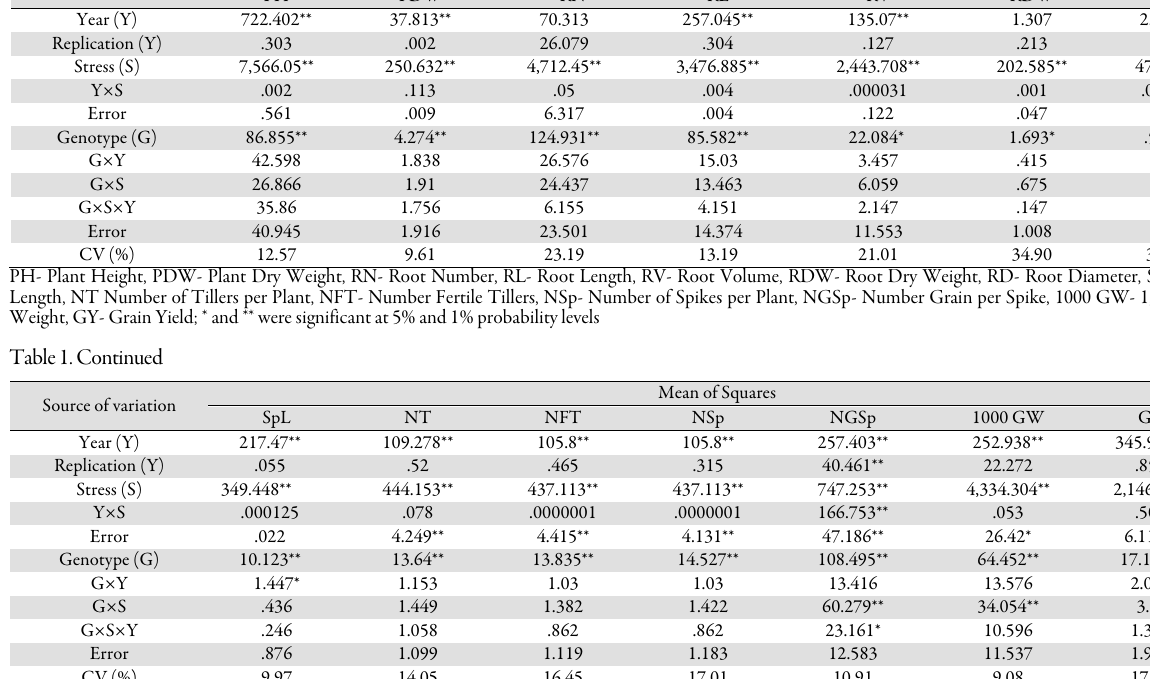
Table 1. Analysis of variance for yield and other traits in spring wheat cultivars under different irrigation treatments Source of variation